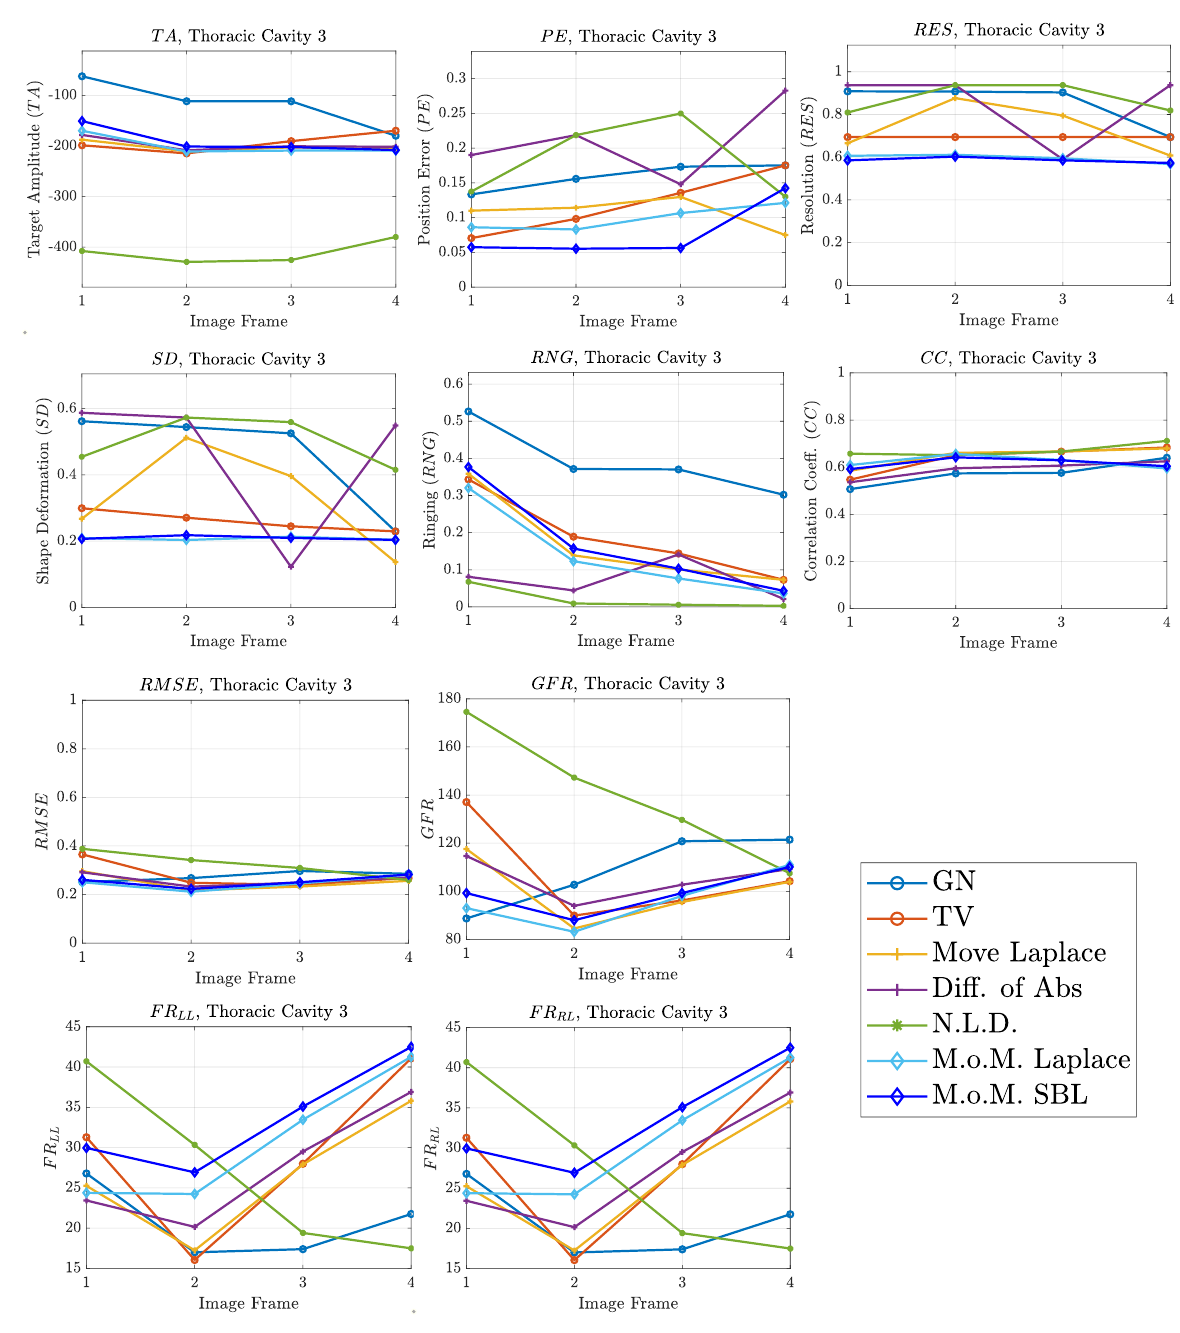
Figure 14. FoM results for the third